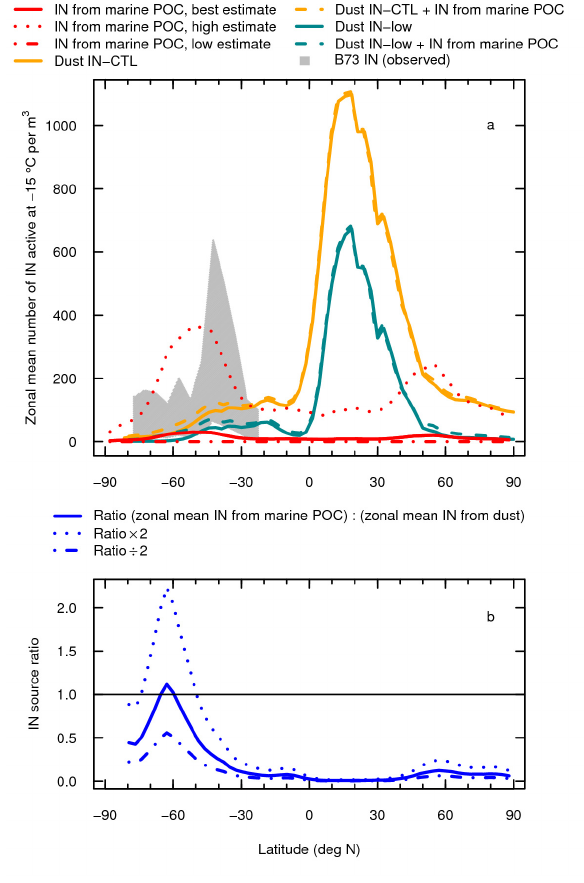
Fig. 7. (a) Latitudinal dependence over oceans of observed IN, and simulated marine biogenic IN and estimated dust IN concentrations. Red lines: results of simulations performed on the basis of POC climatological distribution from MODIS-Aqua (alternative results using chlorophyll climatology are shown in the Supplement). Ob- served zonal mean IN number densities are from B73; the values as reported in B73 form the lower boundary of the shaded region, the “true” IN values are expected to be about a factor of 10 higher, indicated by the upper boundary of the shaded region. Dust IN con- centrations are estimated from two cases of simulated dust number concentrations, a control simulation (CTL; orange solid line) and a simulation with lower dust concentrations (low; turquoise solid line) (Hoose et al., 2010a). The sum of predicted dust IN and ma- rine biogenic IN is shown for the control dust and low dust cases by dashed lines. (b) Ratio of zonal mean marine biogenic IN to zonal mean dust IN, over oceans.